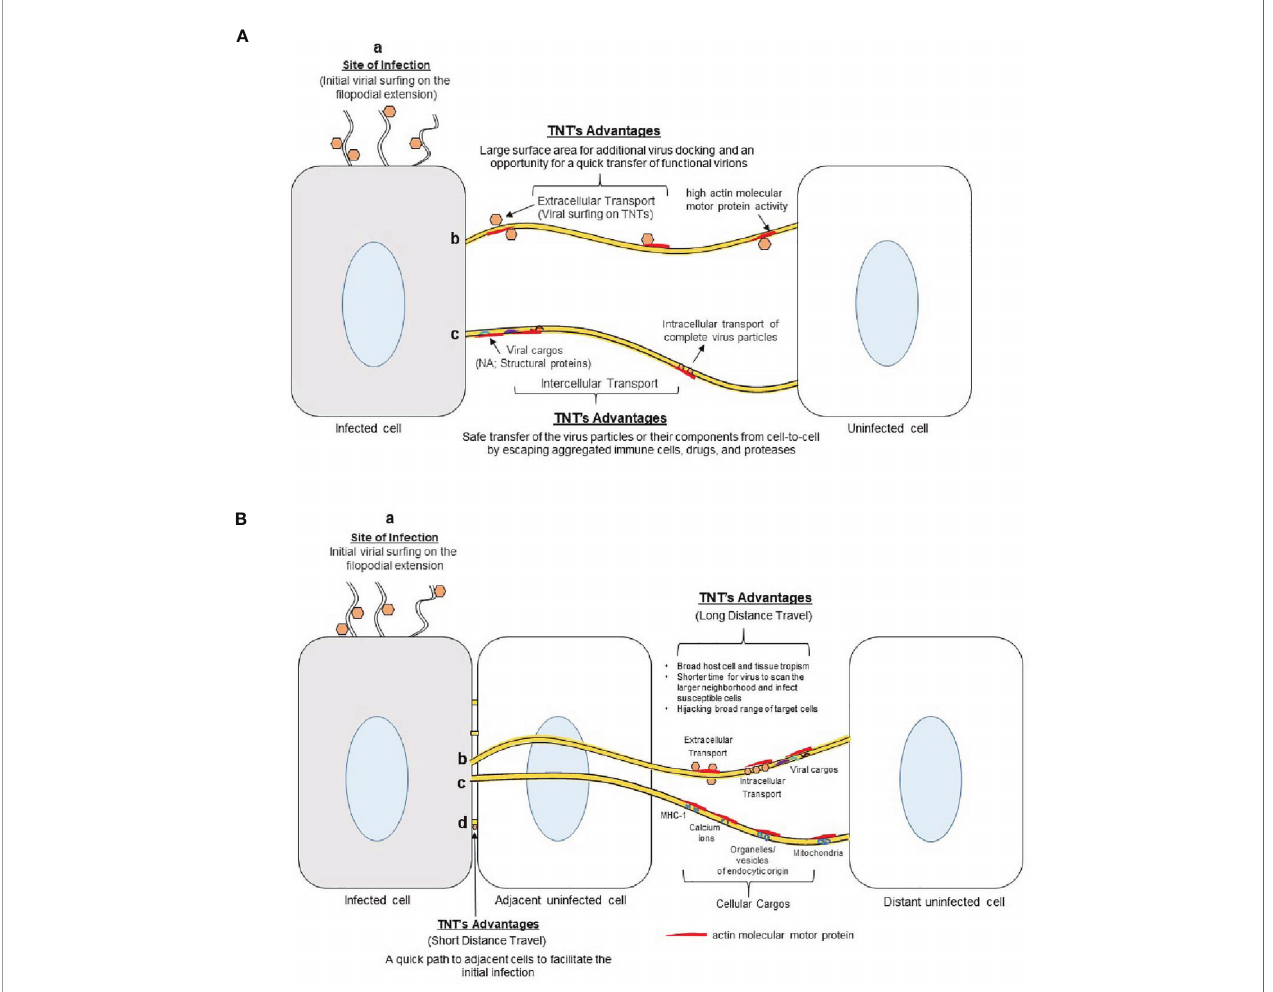
FIGURE 4 | Advantages of using TNTs bridges in viral spread. (A) Viruses use actin-rich fi lopodia to surf to the cell surface. This sur fi ng movement helps the viruses to dock and concentrate at the target cell ’ s surface to facilitate viral attachment and entry. (b) Viruses also surf using TNT bridges to move extracellularly between cells during early phases of infection. The larger surface area provided by the TNTs allows for increased viral docking - an opportunity for quick viral transfer to the nearby cells. (c) The viruses may also use TNTs with or without vesicles to transfer their components (nucleic acid, structural proteins) to neighboring cells during the later stages of infection. TNTs allow the viral structural components to avoid contact with the extracellular matrix (ECM) which can expose them to immune cells, proteases, drugs, or nearby active phagocytic cells. (B) Signi fi cance of TNTs bridges during virus-host interactions. (a) Actin-rich fi lopodia aid in viral sur fi ng to reach the target cell. (b) TNT bridges mediate a long-distance transfer or movement of the virions from the initial infected sites to broaden the virus tropism. (c) Viruses can also use cellular cargos (endocytic vesicle, signaling molecules) to transfer their components or intact virions to reach neighboring cells safely. (d) TNTs also provide essential means to aid the process of viral spread to nearby adjacent